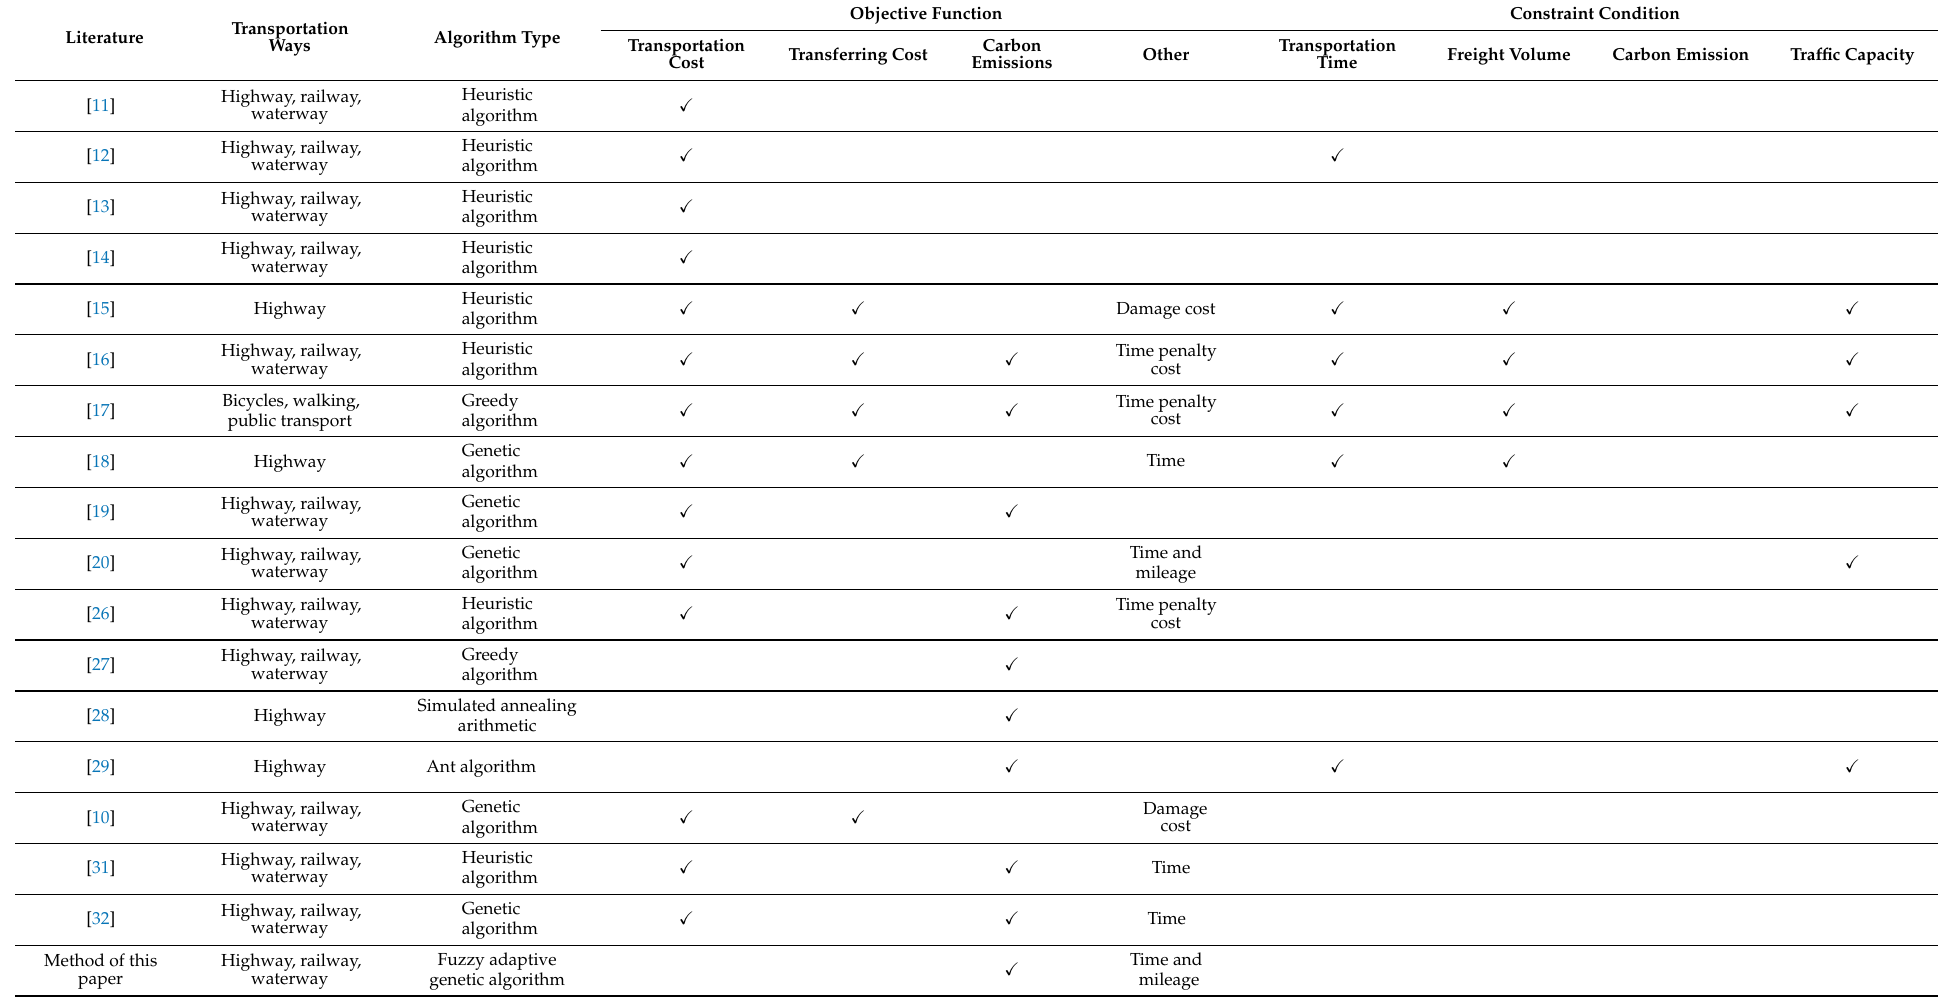
Table 1. Research status